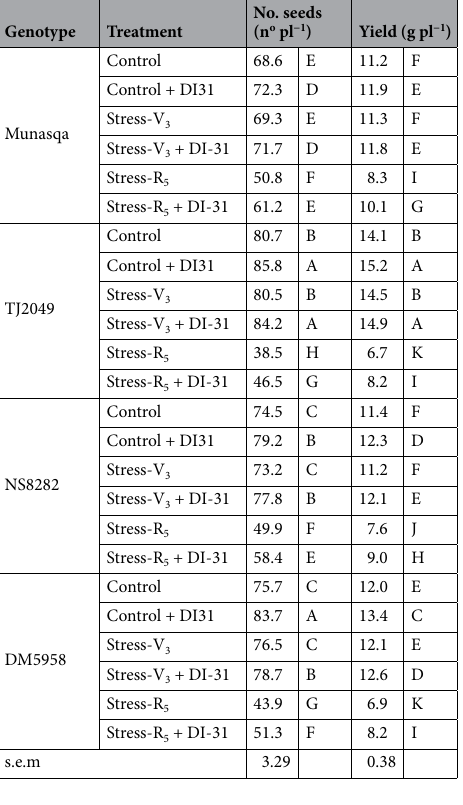
Table 1. Number of seeds and absolute yield per plant of four commercial soybean cultivars foliarly sprayed with distilled water or DI-31 every 21 days and submitted to a 10-day drought period at V 3 or R 5 stages. Average values followed by the same uppercase letter do not differ statistically according to ANOVA with post hoc contrasts by Tukey’s test ( P ≤ 0.05).